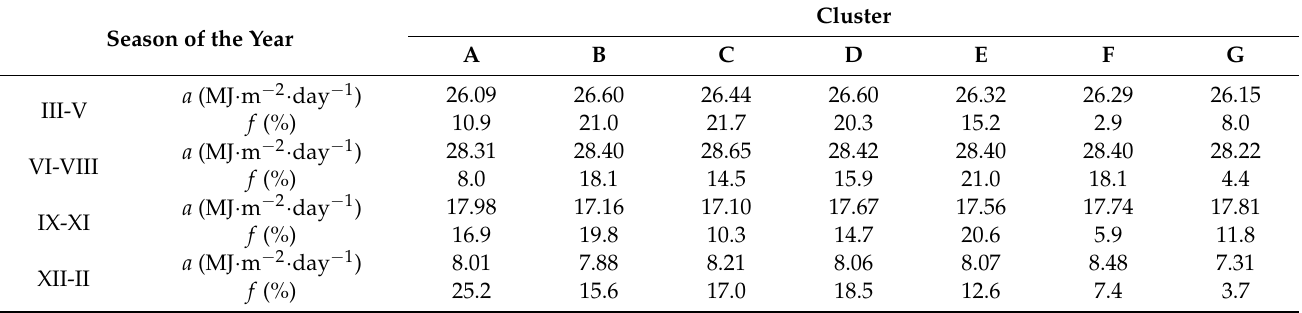
Table 3. The average daily sum of GSR, a (MJ · m − 2 · day − 1 ), over Poland during air inflow from individual clusters and the frequency, f (%), of air inflow from individual clusters on days with extremely large solar radiation sums (above the 0.95 percentile), broken down by seasons of the year (III-V refers to spring, VI-VIII to summer, IX-XI to autumn, and XII-II to winter), during the period 1986–2015. All values are statistically insignificant ( α = 0.05). The letters indicating the clusters correspond to Figure